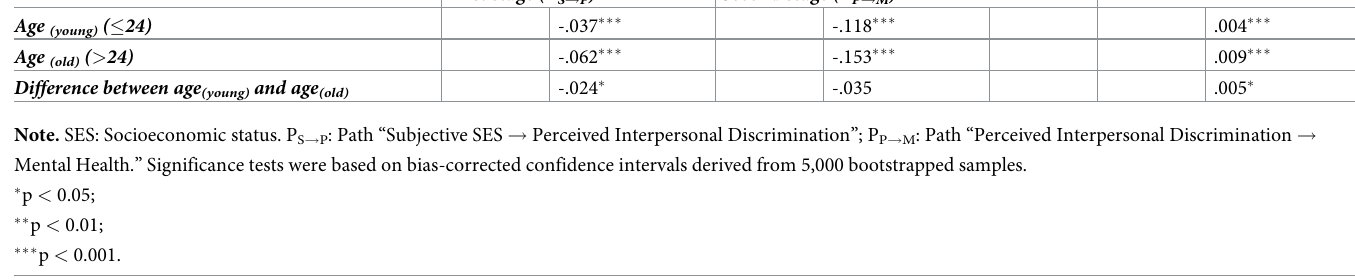
health . For people 24 years of age or younger, the association between subjective SES and dis- crimination (first-stage simple effects of the mediated relationship) ( β = − 0.037; p < 0.001, two − tailed ) and the association between discrimination and mental health (second-stage simple effects of the mediated relationship) ( β = − 0.118; p < 0.001, two − tailed ) were both significant, resulting in a significant indirect effect ( β = 0.004; p < 0.001, two − tailed ). For those over 24 years of age, the first-stage ( β = − 0.062; p < 0.001, two − tailed ) and second-stage ( β = − 0.153; p < 0.001, two − tailed ) simple effects of the mediated relationship were both significant as well, resulting in a significant indirect effect ( β = 0.009; p < 0.001, two − tailed ). Moreover, the indirect effect was significantly stronger in the old-age group than in the young-age group ( Δ β = − 0.005; p = 0.027, two − tailed ); however, the second-stage simple effect did not signifi- cantly differ between the two age groups ( Δ β = − 0.035; p = 0.18, two − tailed ).